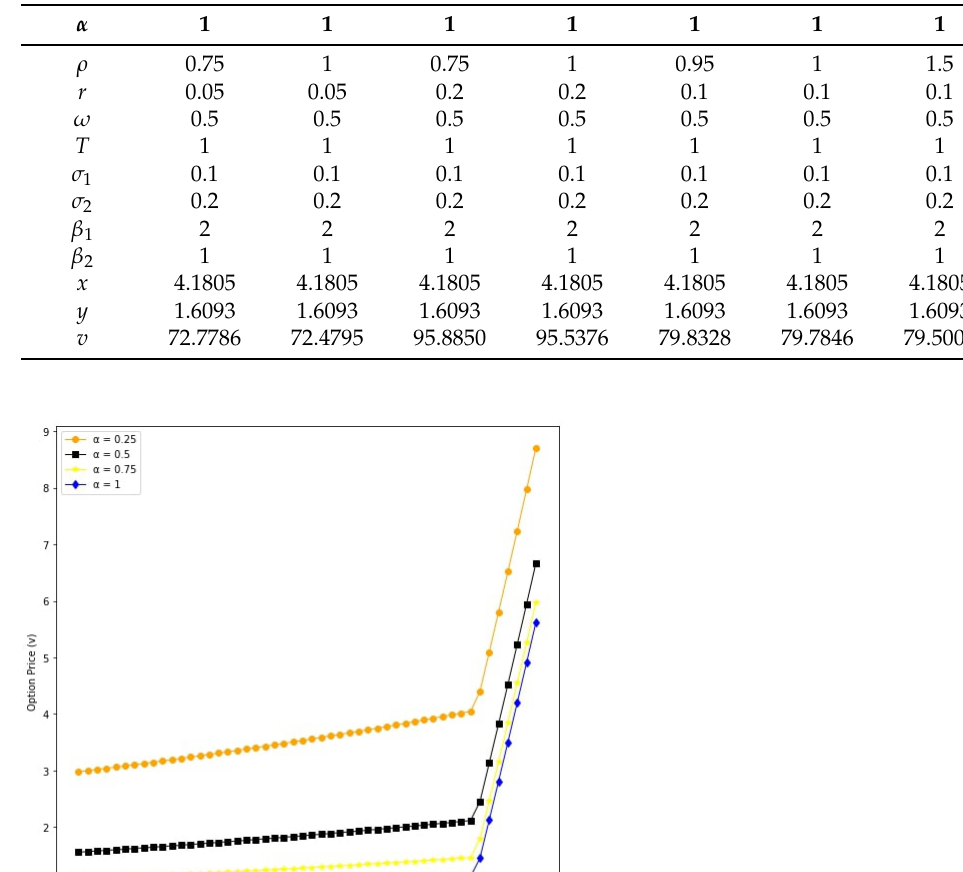
Table 2. Values of European call option.